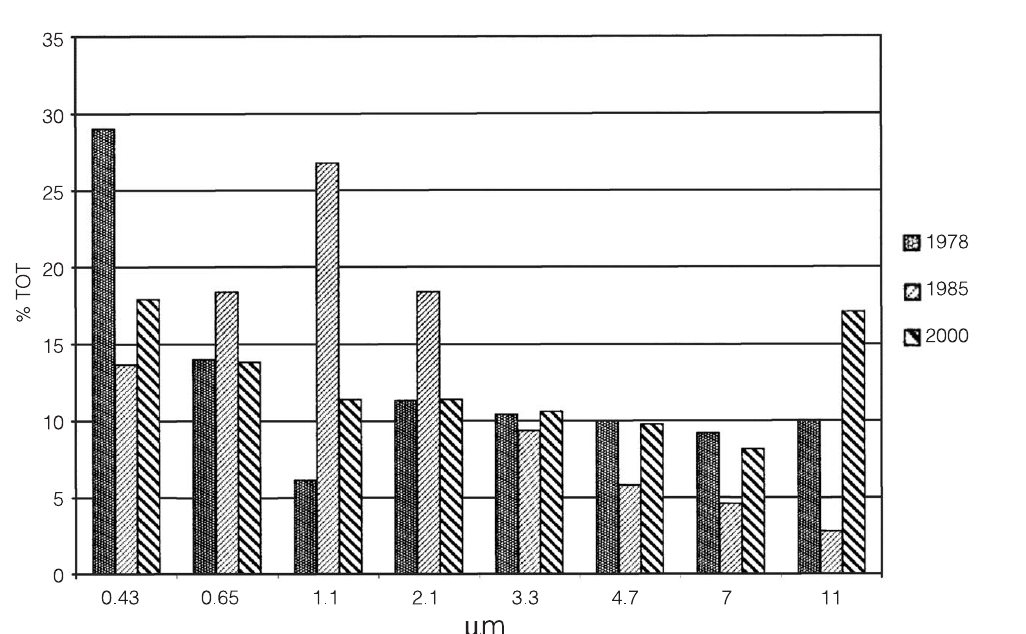
Fig. 6. Granulometric breakdown of particulate matter in 1978, 1985, and